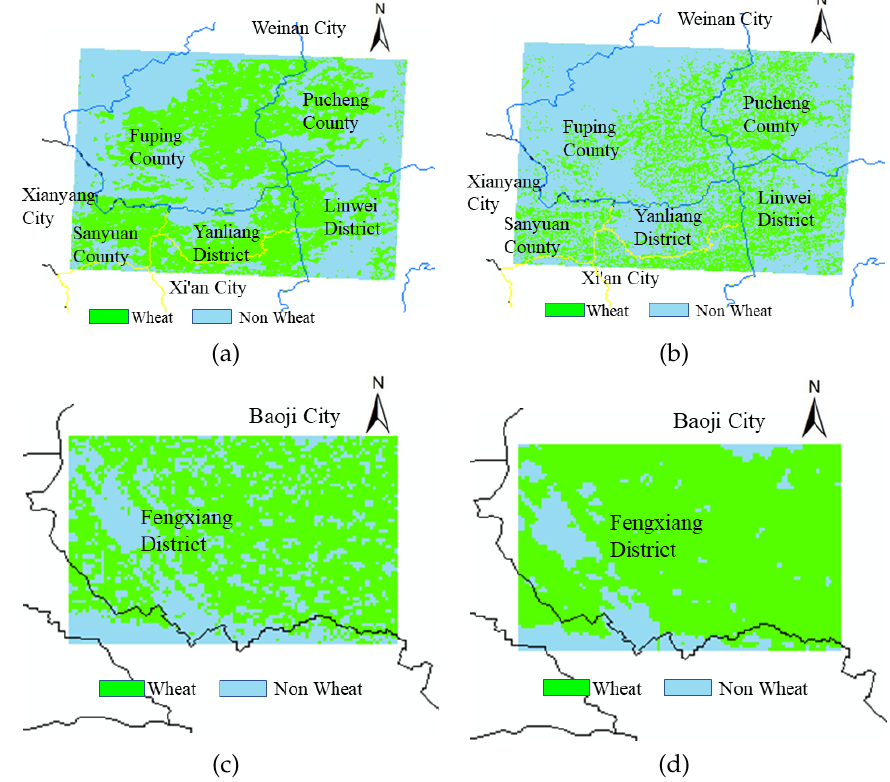
Figure 10. Regional validation at the county scale. ( a , c ) A map of wheat growing areas and non-wheat distribution obtained from MERSI. ( b , d ) A map of wheat growing areas and non-wheat distribution obtained from LANDSAT